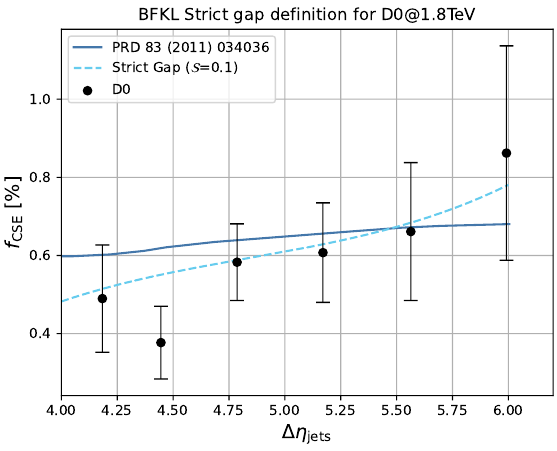
Figure 2 . The CSE event fraction f CSE for D0 conditions [12] in the range p jet2 function of ∆ η with a rapidity-ordered parton shower, no multi-parton interactions, a strict gap jets definition and a scale factor S of 0.1. The full blue line represents the RMK results from ref.